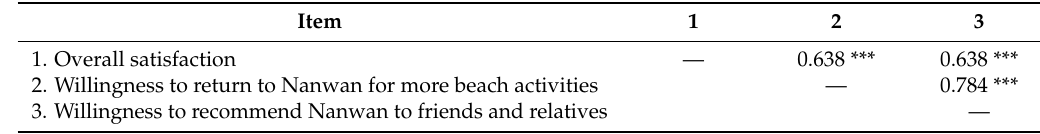
Table 4. Correlation Coefficient Matrix for tourist satisfaction and behavioral intentions.